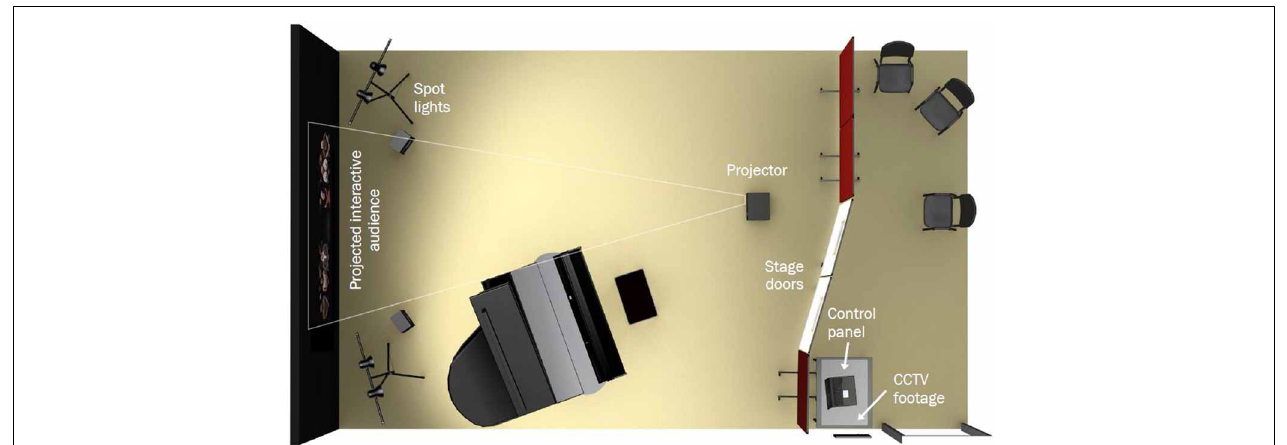
FIGURE 1 | The performance simulator, showing backstage (right) and stage (left) areas. Backstage, CCTV footage of the virtual audience or audition panel is shown on a wall-mounted flat-screen monitor, and controls for operating the audience and audition panel are located on a